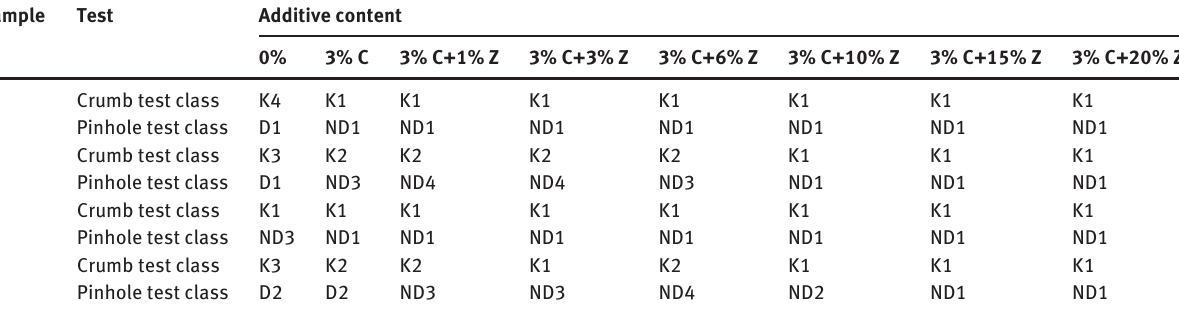
Table 4 Results of dispersibility tests performed on the soil samples mixed with different additive contents.